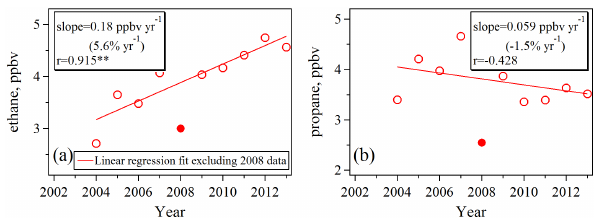
Figure 7. Temporal changes in ambient levels for (a) ethane and (b) propane measured at the PKU site during August from 2004 to 2013. The solid red lines represent linear regression fits for ethane and propane mixing ratios excluding data for August 2008 (the red filled